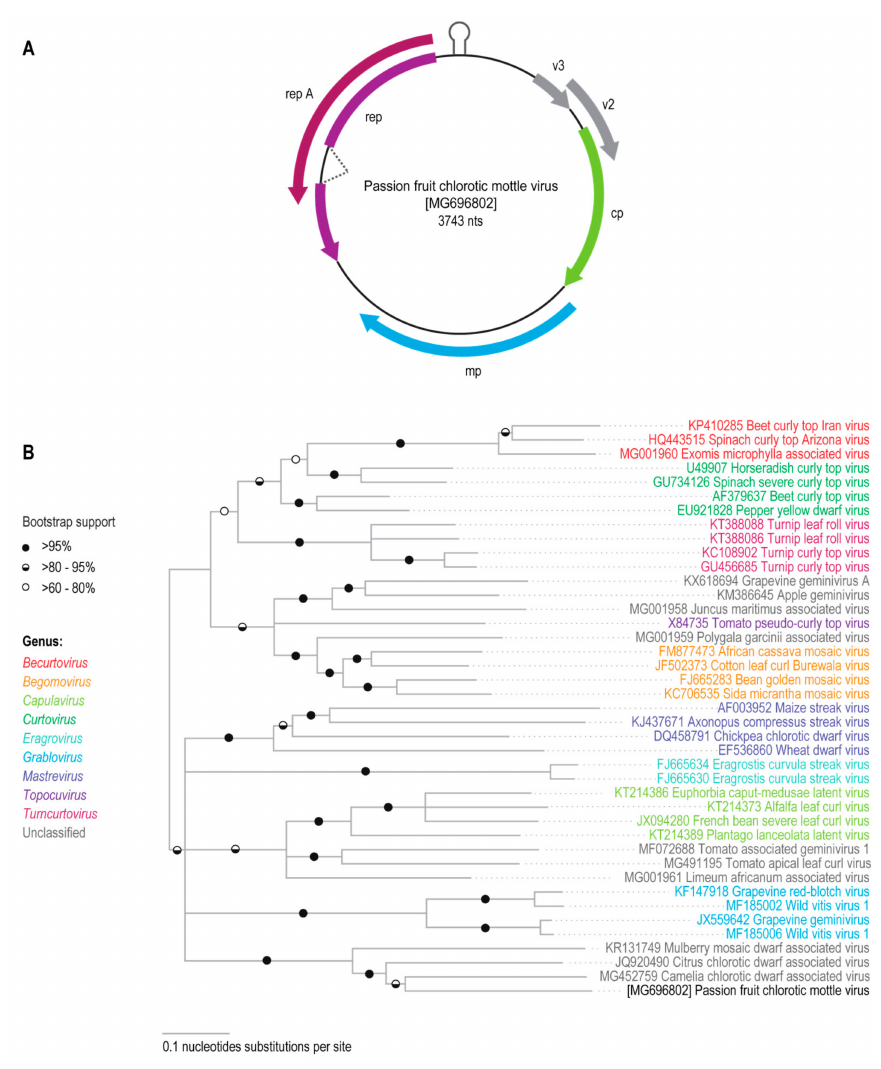
Figure 1. ( A ) Genome organization of passion fruit chlorotic mottle virus (PCMoV); ( B ) Midpoint rooted Neighbor-joining tree with Jukes-Cantor substitution model and 1000 bootstraps iterations for the genomes (or DNA-A) sequences of representative geminiviruses and PCMoV identified in this study. Branches with <60% bootstrap support were